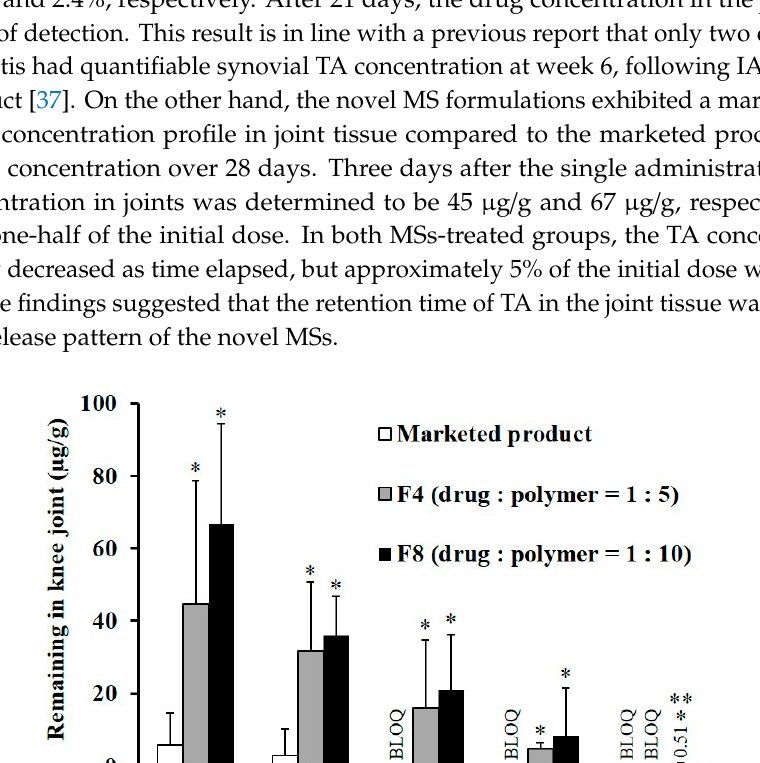
Table 3. Pharmacokinetic parameters of TA in plasma following IA administration of the marketed product, F4, and F8 in rats.